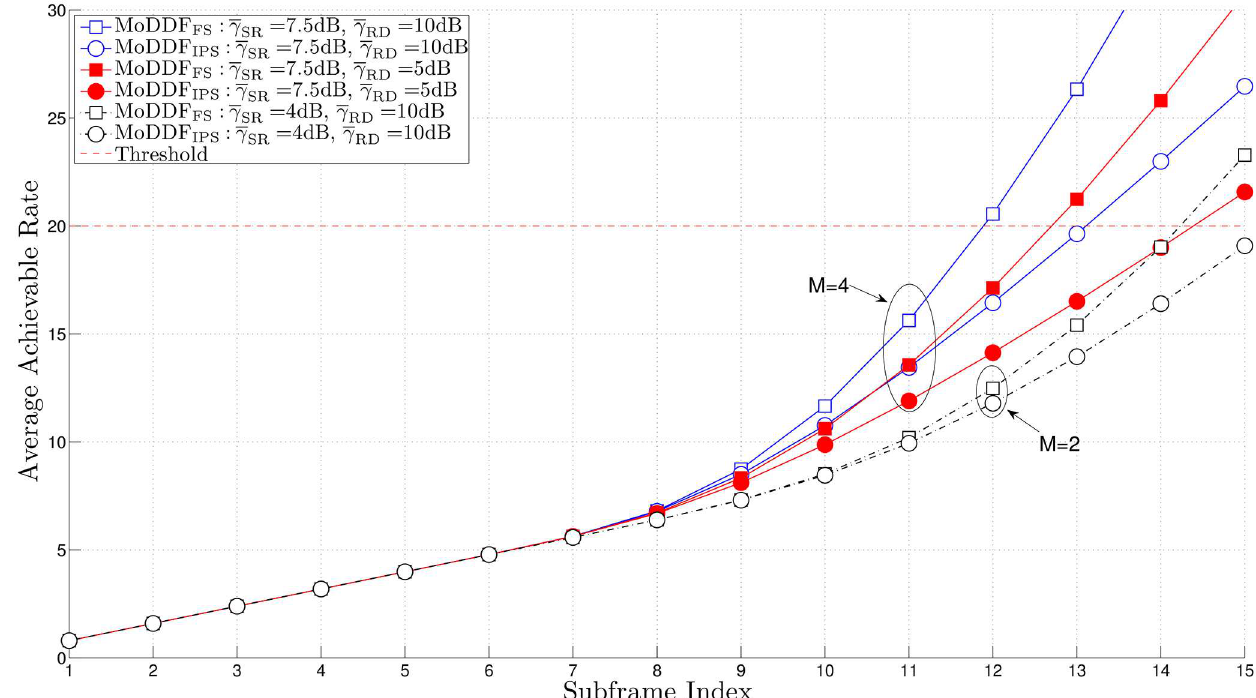
¼ 2 dB, and R th = 20. SD